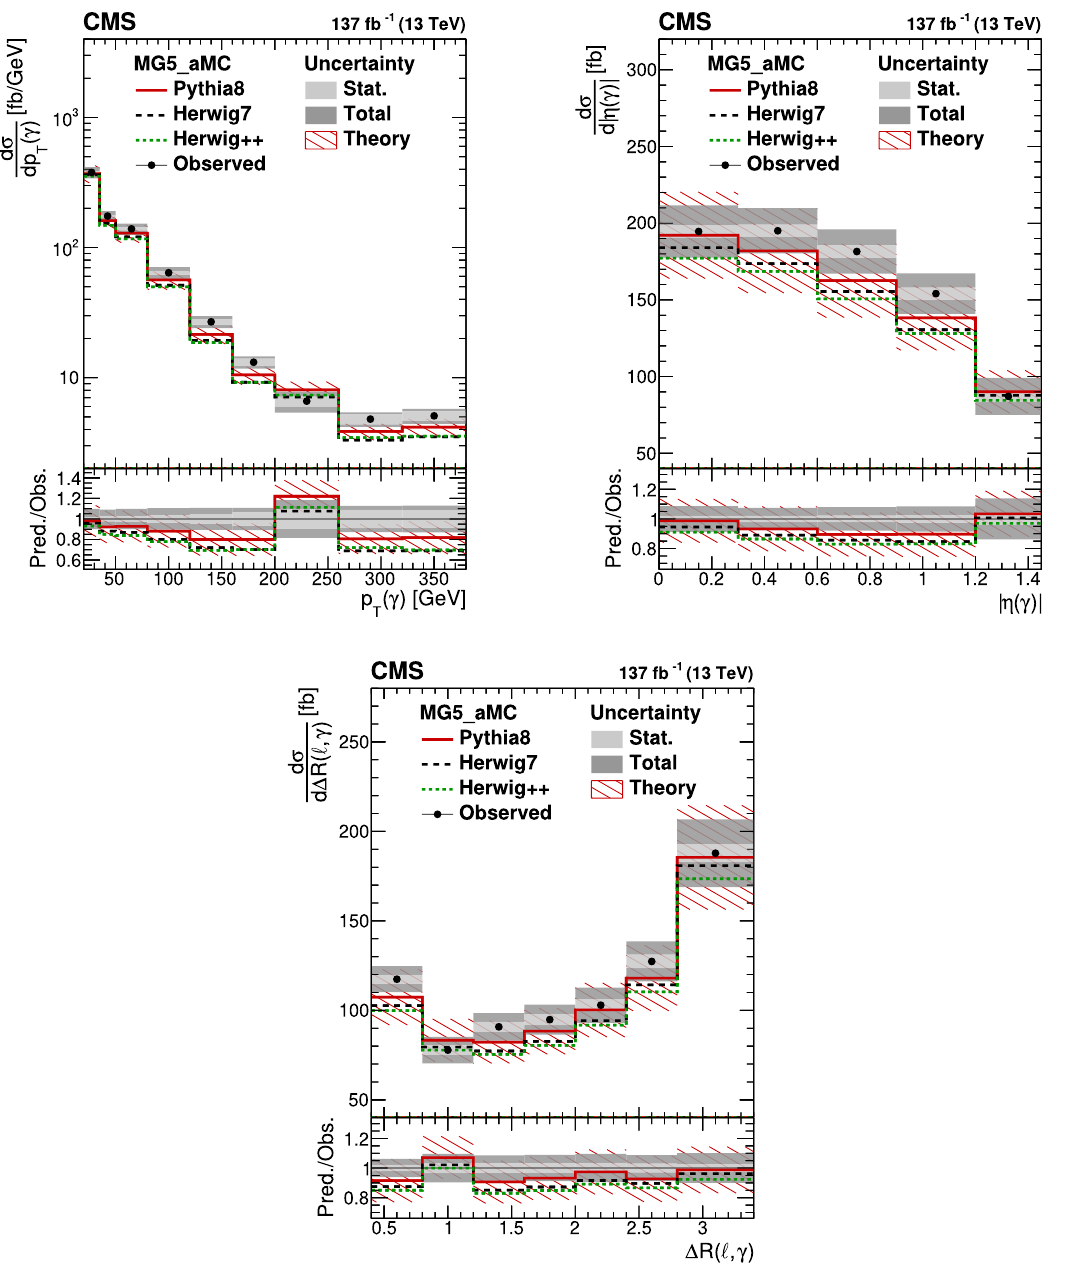
( γ ) (upper left), | η ( γ ) | (upper right), Figure 9 . The unfolded differential cross sections for p T and ∆ R ( ‘, γ ) (lower) compared with simulation obtained from the MadGraph 5_a mc@nlo event generator interfaced to pythia (red, solid), herwig 7 (black, dashed) and herwig++ (green, dot- ted) for the parton shower and hadronization. For p ( γ ) and ∆ R ( ‘, γ ) , the last bin includes the T overflow. The lower panel displays the ratio of simulation to the observation. The inner and outer bands show the statistical and total uncertainties, respectively. Photons radiated from leptons and satisfying ∆ R ( ‘, γ ) > 0 . 4 are included in the signal and contribute significantly to the first bin of the differential ∆ R ( ‘, γ ) cross